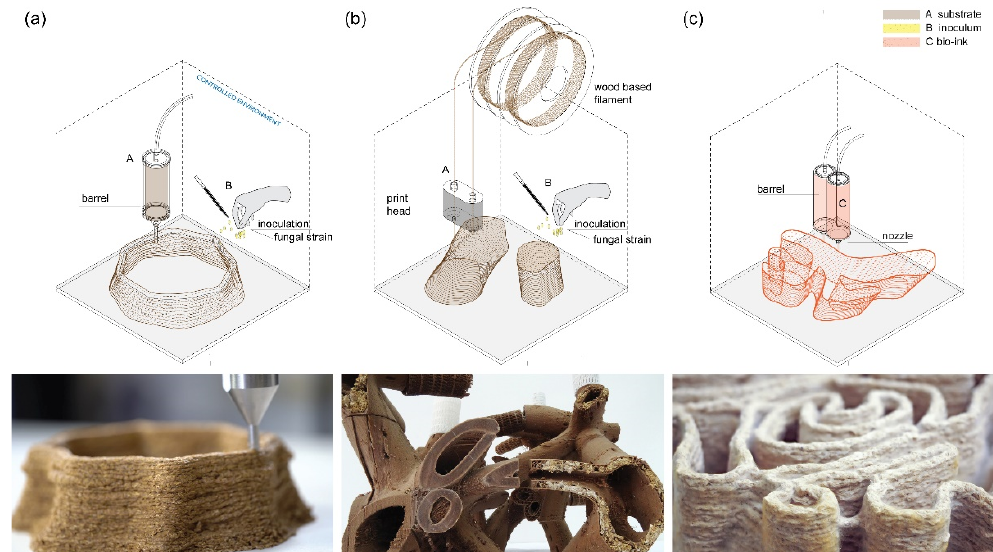
Figure 5. Current additive manufacturing approaches for mycelium-bound composites: ( a ) substrate core deposition [52] (Julia Krayer and Fraunhofer UMSICHT © 2022); ( b ) filament-based scaffolds [55] (reprinted with permission from Alima et al., Proceedings of the 2021 DigitalFUTURES; 2022); and ( c ) bio-inks [59] (reprinted with permission from Goidea et al., Pulp Faction: 3d Printed Material Assemblies through Microbial Biotransformation; published by UCL Press, 2020).